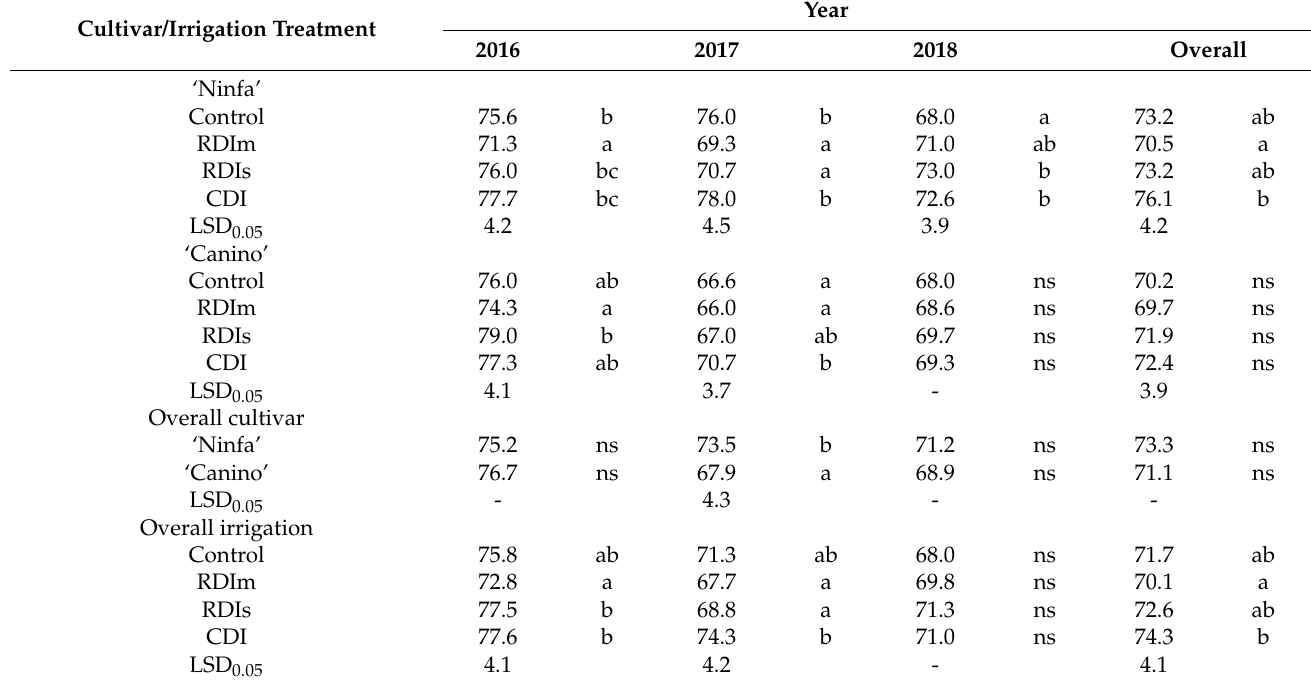
Table 5. The effects of three years (2016, 2017, 2018), deficit irrigation treatments (control, moderate regular deficit irrigation—RDIm, severe regular deficit irrigation—RDIs and continuous deficit irrigation—CDI) and two cultivars (‘Ninfa’ and ‘Canino’) on starting date of flowering (SDF) in a commercial apricot orchard at Wadi El Natrun, Northern Egypt. Explanation for irrigation treatments, calculations of significant differences, and explanations for LSD 0.05 values are given in Figure 3; ns: nonsignificant. Different letters represent significant differences among DI treatments. Cultivar/Irrigation Treatment